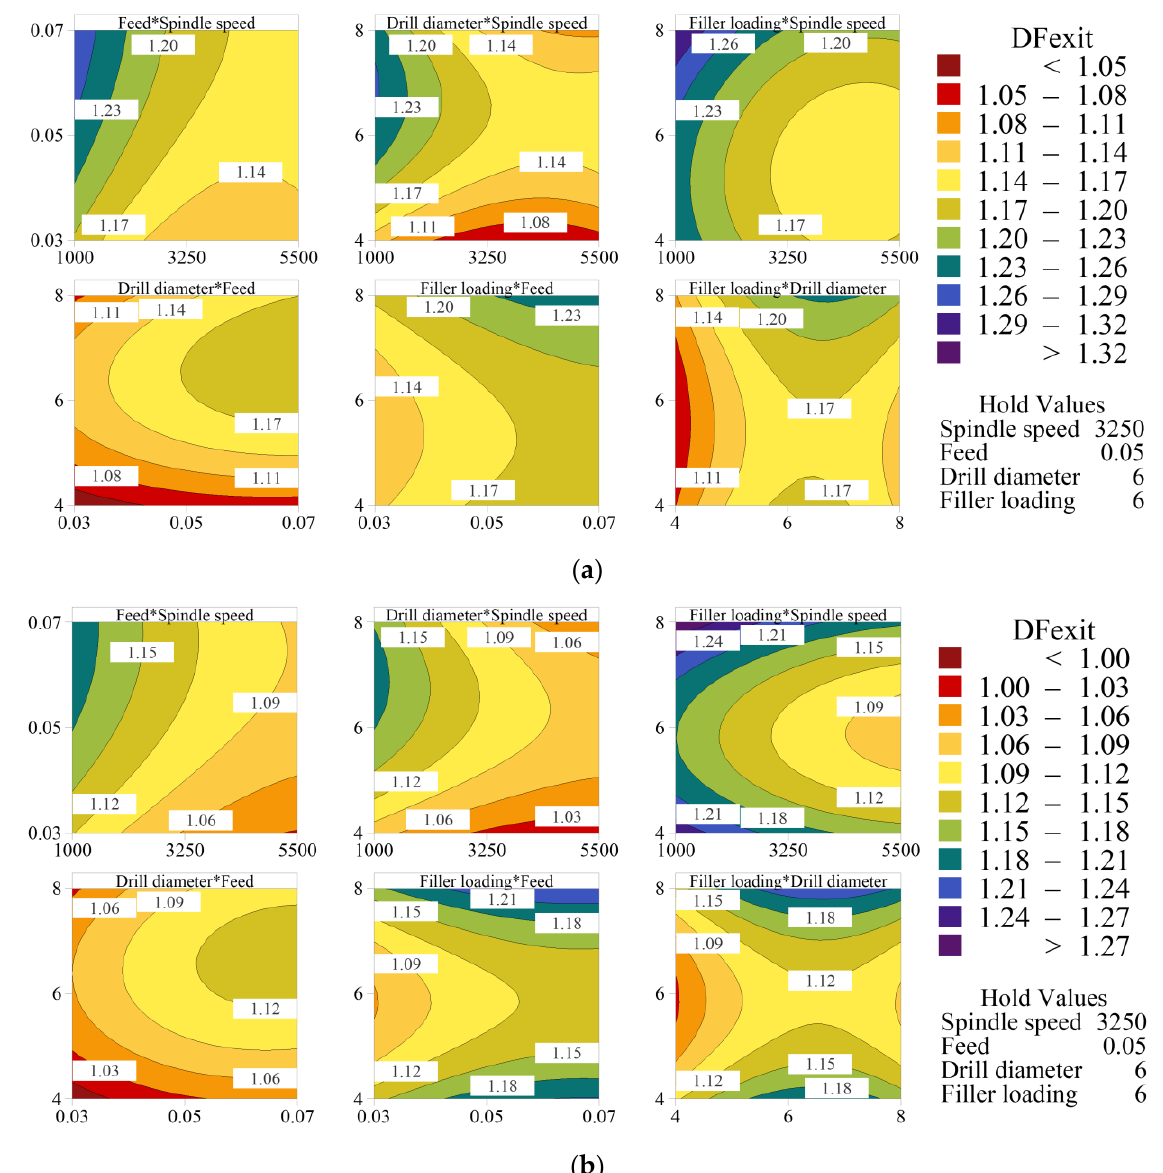
Figure 18. Delamination contour plot of ( a ) MoS 2 -loaded CEC and ( b ) h-BN-loaded CEC.